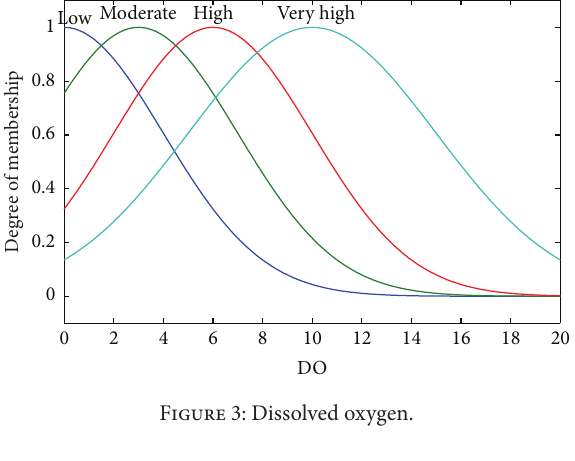
Figure 5: pH factor.